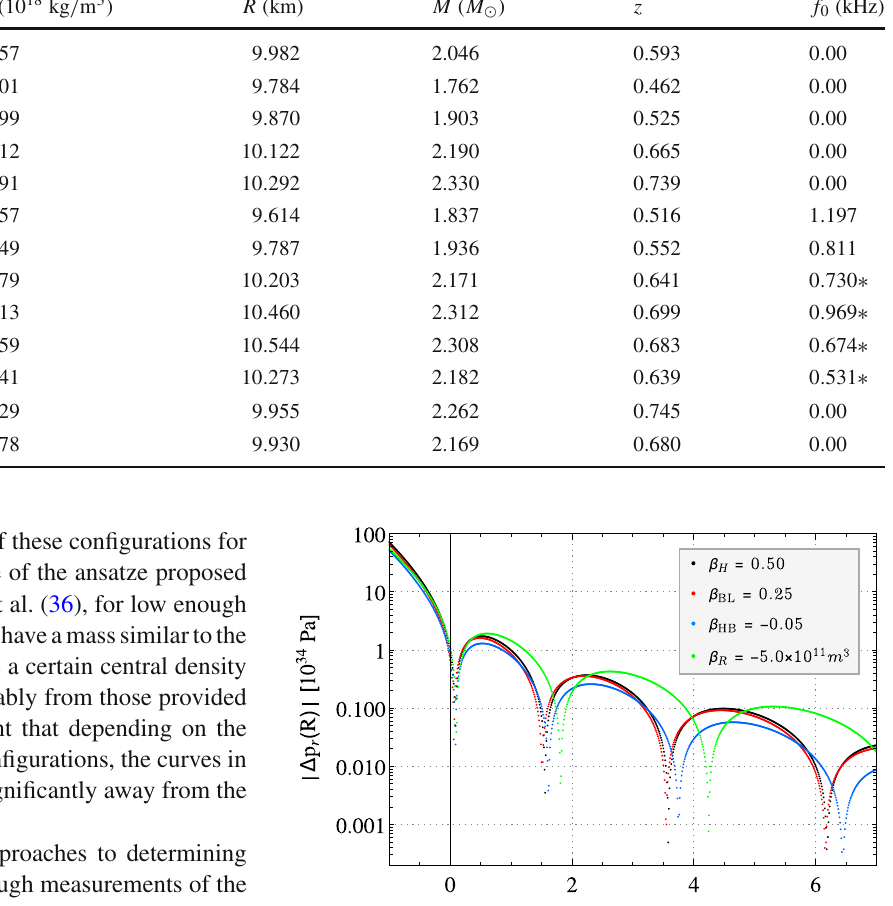
Table 1 Maximum-mass stellar configurations with SLy EoS for dif- ferent values of the anisotropy parameter. The mass density values cor- respond to the critical central density where the function M (ρ c ) is a